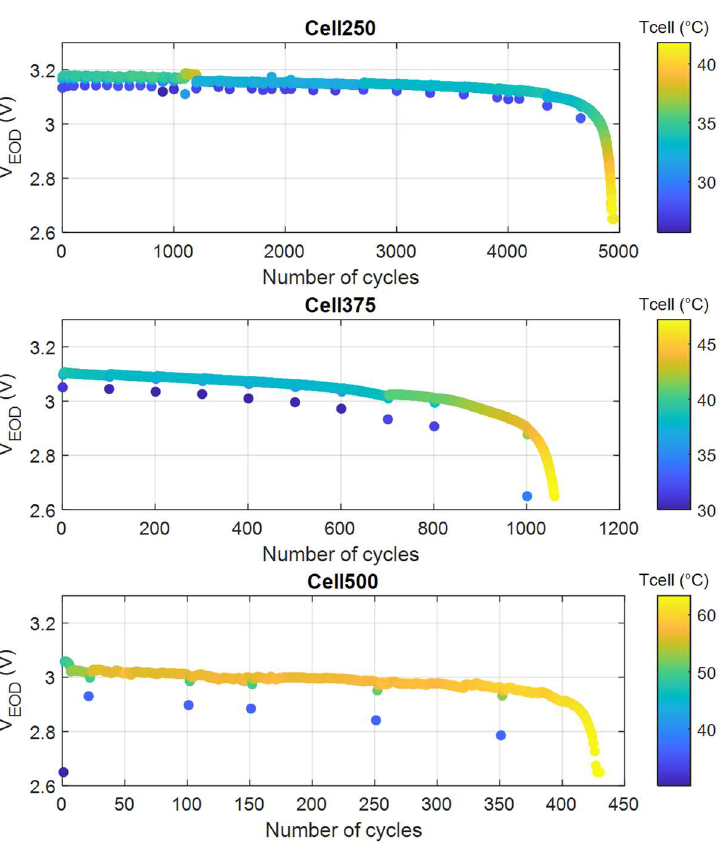
Figure 5. End-of-discharge voltage as a function of the number of cycles performed and of the cell case temperature. case